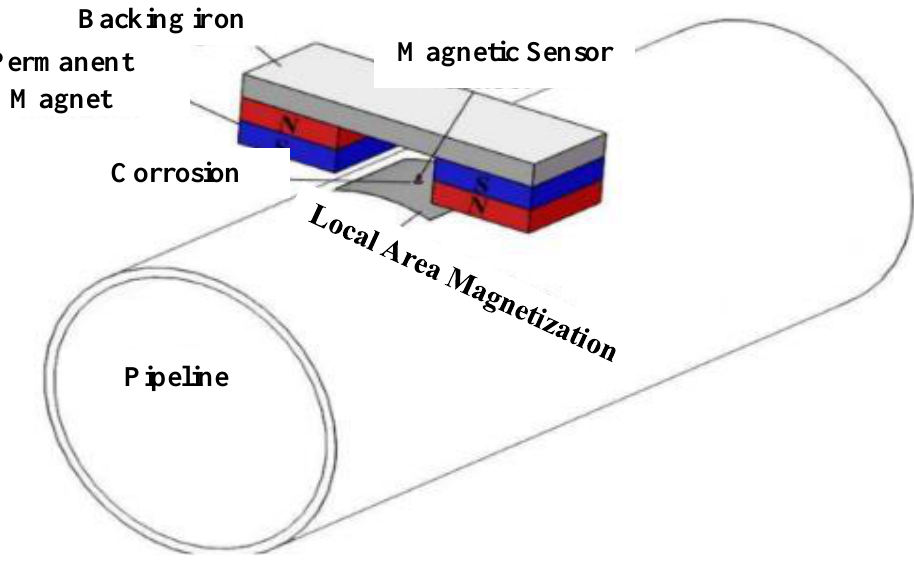
Figure 8. MFL framework for corrosion detection and monitoring